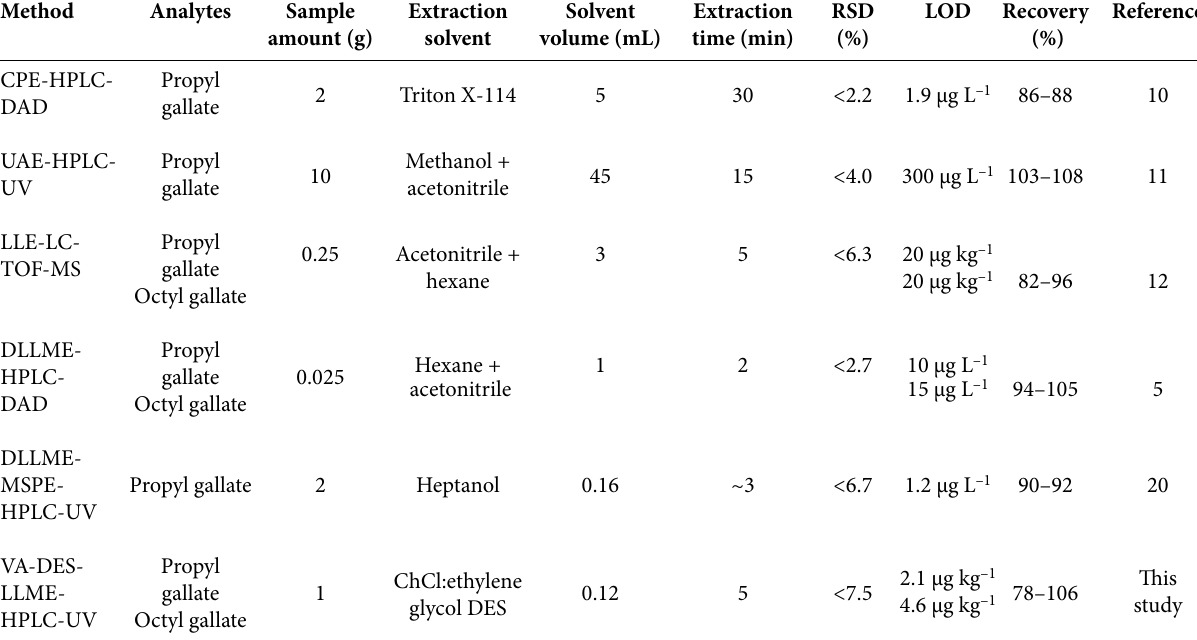
Table 4. Comparison of the proposed method with other methods used in determination of alkyl gallates in vegetable oil samples.